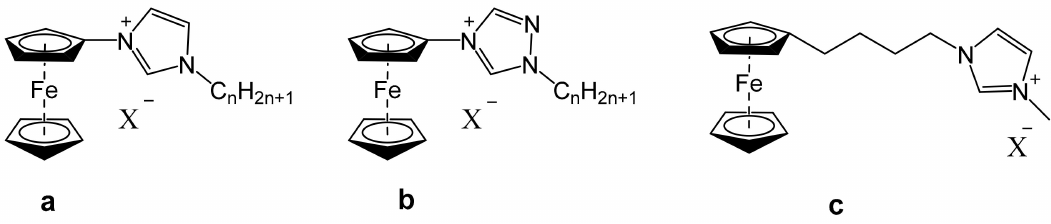
Figure 2. 1-Ferrocenyl-3-alkylimidazolium ( a ); 1-ferrocenyl-4-methyltriazolium ( b ), and 1-(ferrocenylbutyl)-3-methylimidazolium ( c )